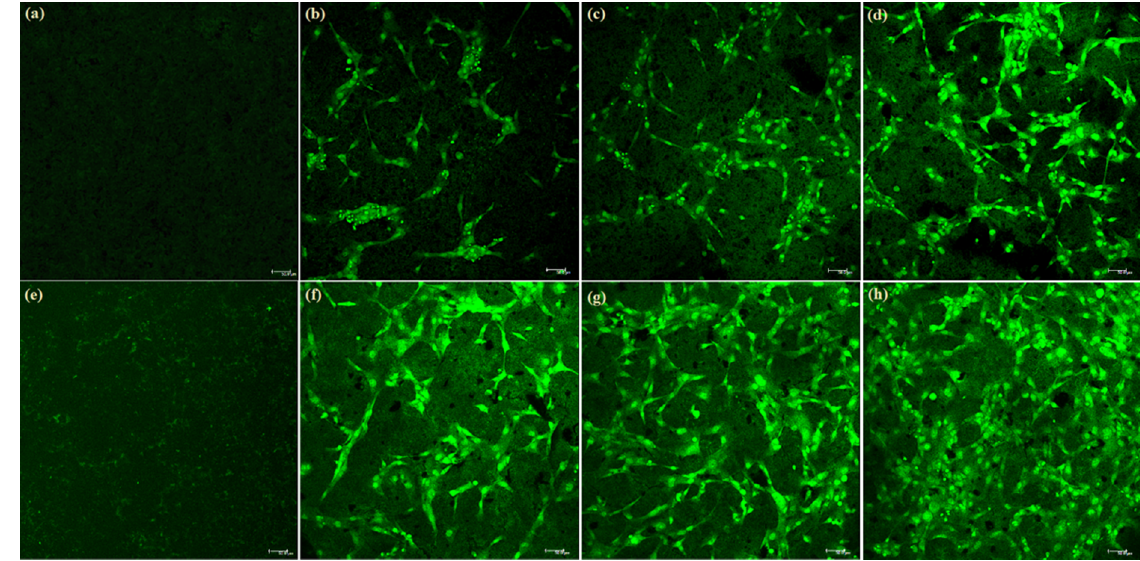
Figure 11. Comparison of the cell adhesion and proliferation on pure CS and 1 wt.%GNP/CS composite surfaces at different time points: (a) blank of pure CS, (b-d) 1, 3 and 5 days on pure CS discs, (e) blank of 1 wt.%GNP/CS, (f-h) 1, 3 and 5 days on 1 wt.%GNP/CS composite. The scale bar represents 50 m m.